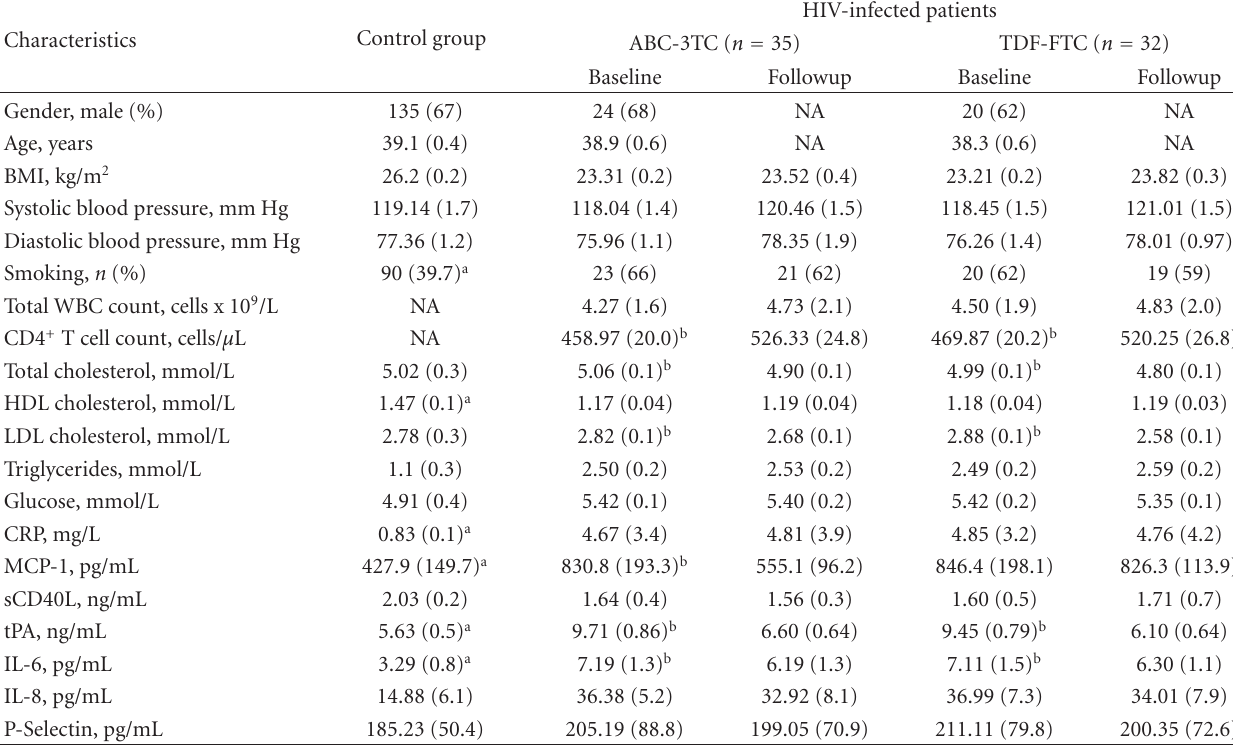
Table 1: Characteristics of the control group ( n = 151) and HIV-infected patients ( n = 67) at baseline and at follow-up by treatment group.